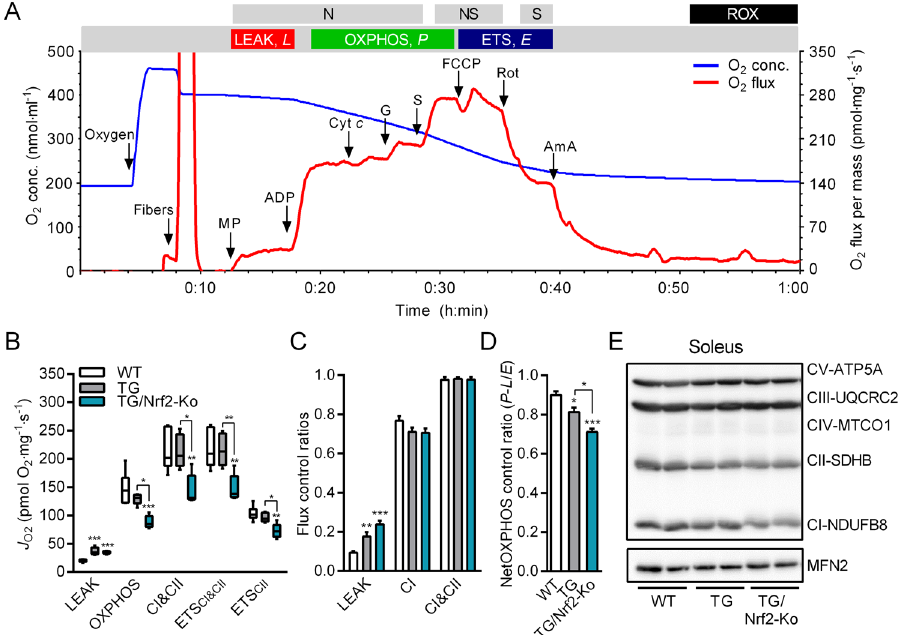
Figure 3. Skeletal muscle fiber mitochondrial respiratory capacity in male TG/Nrf2-Ko mice. ( A ) Representative trace of oxygen (O 2 ) concentration (blue line) and O 2 flux (red line) during substrate-uncoupler- inhibitor-titration (SUIT) protocol for mitochondrial (mt) respiratory capacity in permeabilized mouse soleus muscle fibers, NADH-linked substrates (N-pathway, N), combined with succinate (NS-pathway, NS) and CI- inhibitor rotenone (S-pathway, S): Oxygen (elevation of O 2 levels in respirometry chambers with permeabilized muscle fibers to avoid the development of an artificial hypoxic or anoxic core in the nonperfused fiber bundle), Fibers (1–2 mg saponin-permeabilized fibers), MP (Malate + Pyruvate; LEAK respiration), ADP (N-OXPHOS capacity), Cyt c (cytochrome c, integrity of outer mt-membrane), G (glutamate; N-OXPHOS capacity), S (succinate; NS-OXPHOS capacity), FCCP (NS-ETS capacity, ETS CI&CII ), Rot (rotenone; S-ETS capacity, ETS CII ), Ama (antimycin A; less than 2% residual oxygen consumption, ROX). ( B ) Mitochondrial respiratory capacity ( J O2 ) of oxidative soleus skeletal muscle fibers of 40 wks old male animals (n = 4–5) and ( C ) corresponding flux control ratios and O 2 fluxes normalized to ETS CI&CII . ( D ) NetOXPHOS control ratio ( ≈ ( P − L )/ E , expresses the OXPHOS capacity (corrected for LEAK respiration) as a fraction of ETS capacity). ( D ) Representative immunoblots of respiratory chain complexes in soleus muscle of 40 wks old male animals using Mitofusin2 (MFN2) as loading control (2 samples shown out of 4–5 analyzed per group). All absolute values are expressed as box-and-whisker plots, relative or normalized data are expressed as means + SEM; * p < 0.05; ** p < 0.01; *** p <